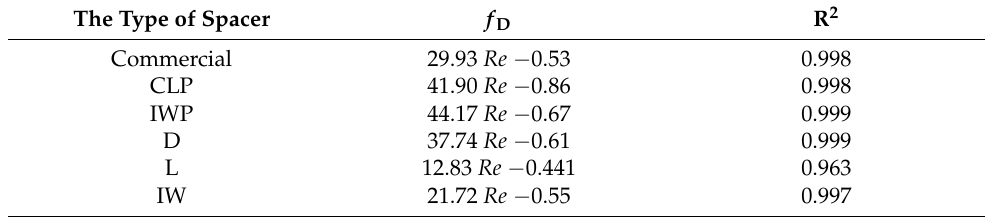
Table 3. The power–law correlation between f D and Re in all spacer-filled channels.